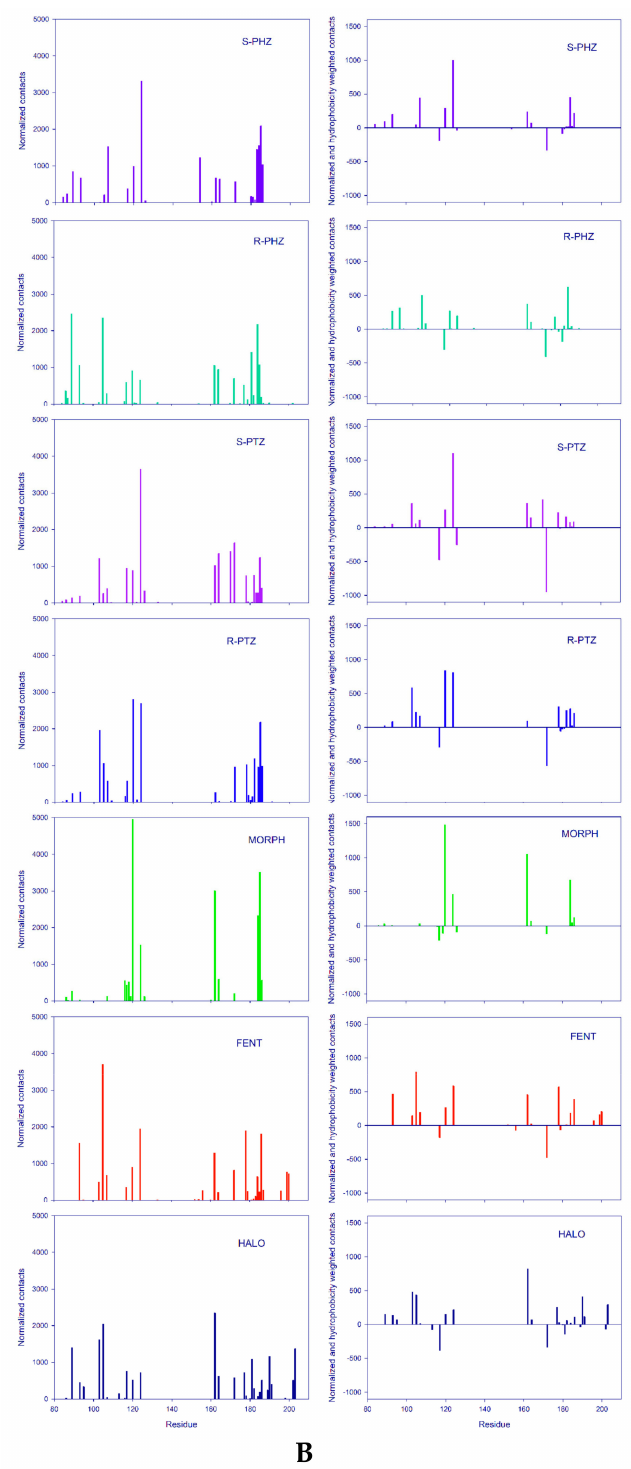
Figure 4. ( A ) (a–g) Normalized spectrum of the frequency of the contacts between receptor residues and the ligands; ( B ) On the left: Normalized spectrum of the frequency of the contacts between receptor residues and the ligands. On the right: Spectrum of the frequency of ligand contacts with receptor residues normalized according to the hydrophobic scale taken from Reference [46]. The positive bars correspond to hydrophobic contacts while negative bars correspond to hydrophilic